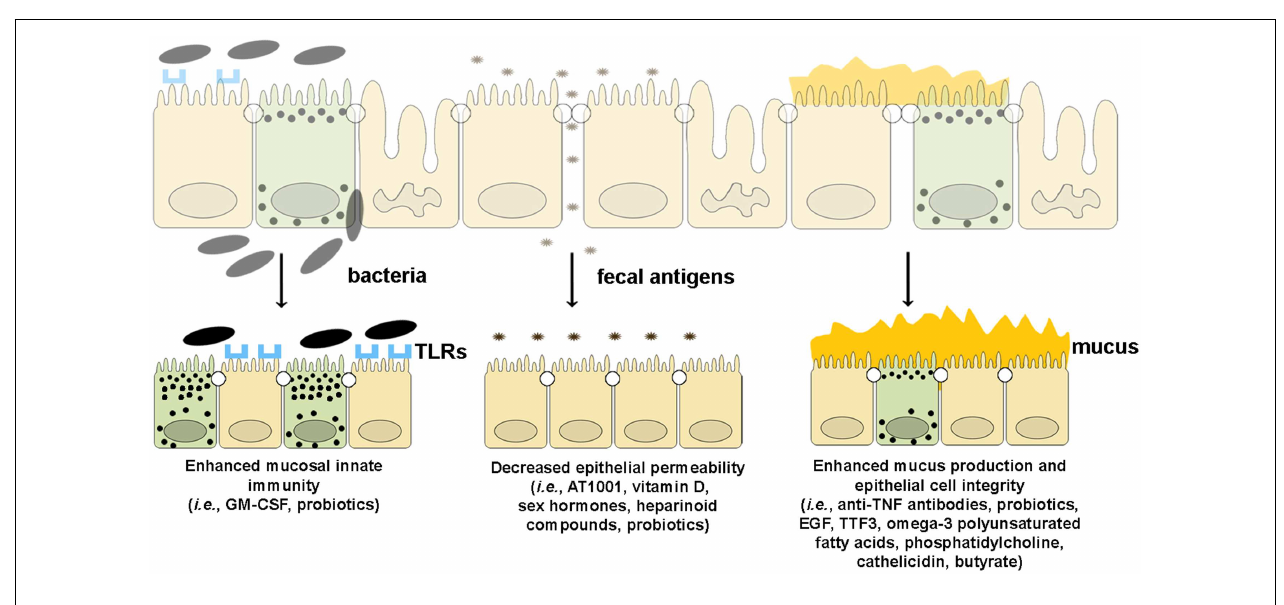
anti-microbial peptides, (2) decreasing epithelial permeability through the expression and assembly ofTJ and AJ proteins, and (3) restoring epithelial cell and mucus layer integrity by reducing IEC apoptosis and inducing mucus